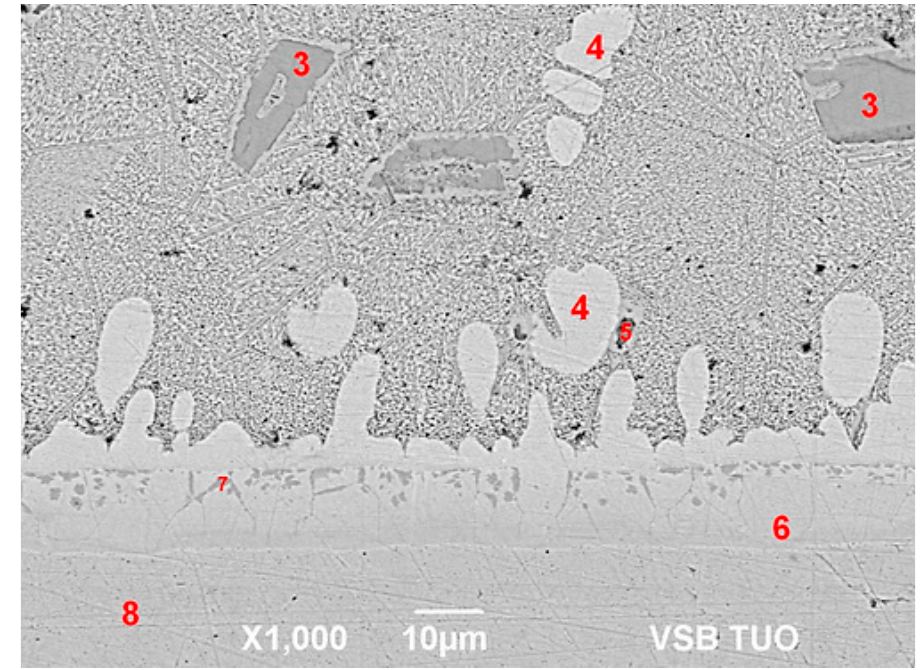
Figure 17. Isopletic section of ternary system Al-Cu for 40 wt % of Zn [22].